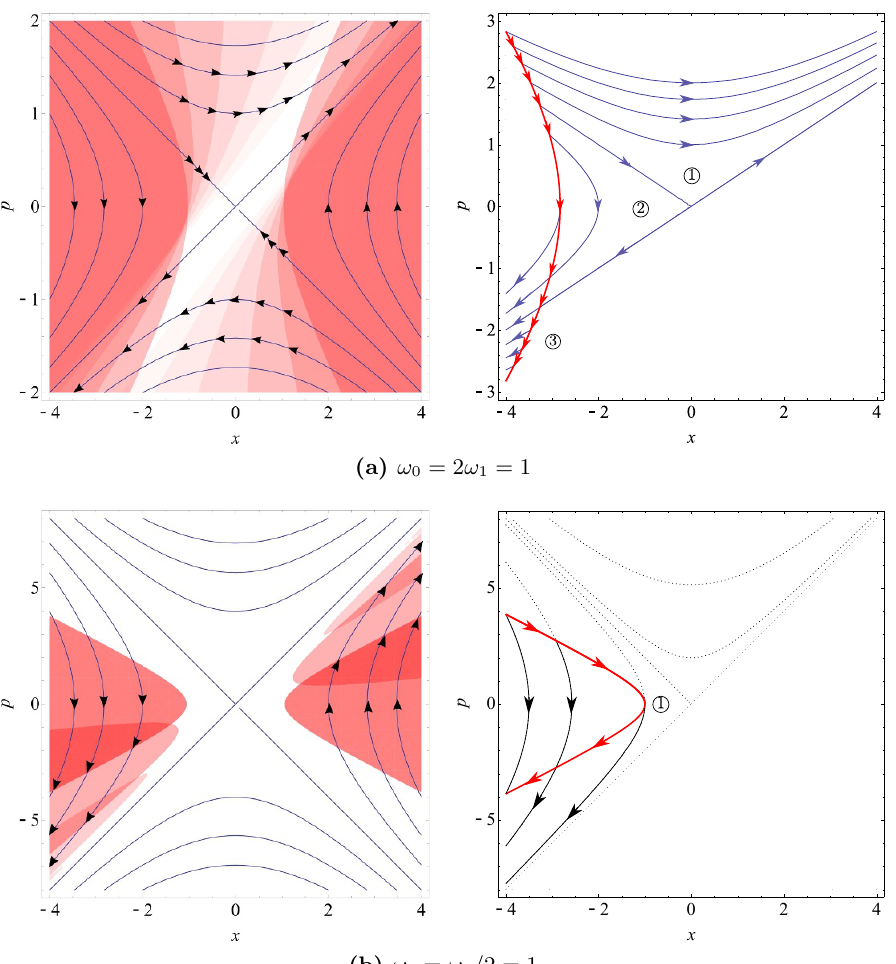
Figure 15. The formation of Fermi surface (5.4). Left: the Fermi surfaces are plotted more transparently as time evolves. Solid lines are equi-energy surfaces i.e. the trajectories of classical particles after abrupt quench. The directions of particle motion are labeled by arrows. Right: the original Fermi surface when (cid:28) (cid:20) 0 is plotted in solid red with arrows pointing in the directions of classical particles. Blue or black solid lines are the trajectories of classical particles after abrupt quench. The orientations of motion are labeled by arrows. Dashed black lines are equi-energy surfaces.